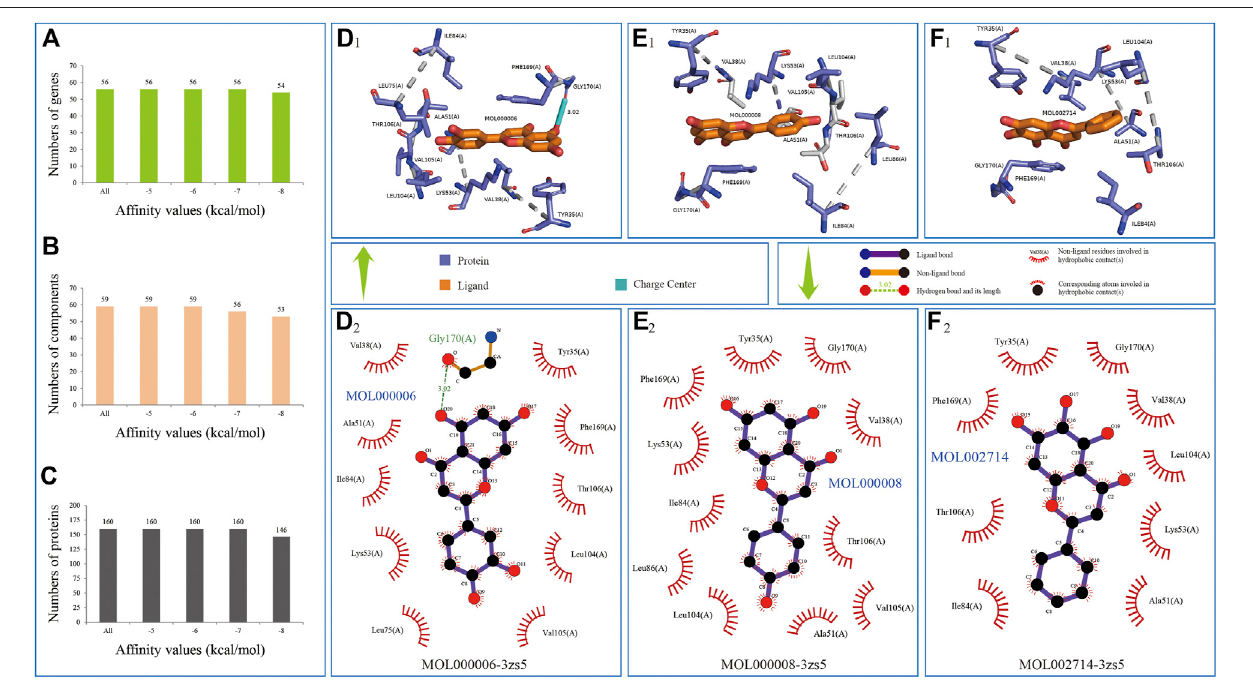
FIGURE10| Three binding relationships indocking predictions. Ingredientiscolored byelements inyellow; thecombined location betweeningredientand protein colored by elements in green and blue (D 1 -F 2 ) represent the bindings of MOL000006-3zs5, MOL000008-3zs5, and MOL002714-3zs5, respectively.